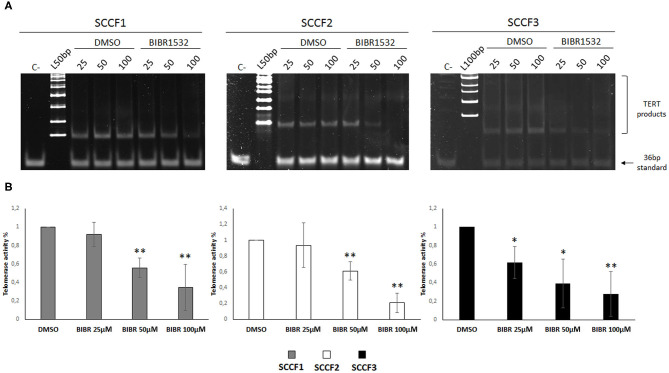
BIBR1532 down-regulates telomerase activity (TA) in a dose-dependent manner in FOSCC cell lines. (A) SCCF1, SCCF2, and SCCF3 were treated with BIBR1532 at 25, 50, and 100 μM vs DMSO and analyzed by telomeric repeat amplification protocol (TRAP) assay. Representative gels out of at least three independent experiments are illustrated (C–: negative control, sample with no lysate; L100bp: 100 bp DNA ladder, the first band from the bottom is 100 bp; L50bp: 50 bp DNA ladder, the first band from the bottom is 50 bp). (B) Quantification of TA by densitometric analysis of gel scans. Data were calculated as the ratio between TERT products ladder and 36 bp internal standard and represent the mean ± standard deviations of at least three independent experiments. Changes in TA were calculated and expressed as % for each BIBR1532 dose compared with its respective DMSO control set as 100% (statistically significant, *P < 0.05; **P < 0.01).